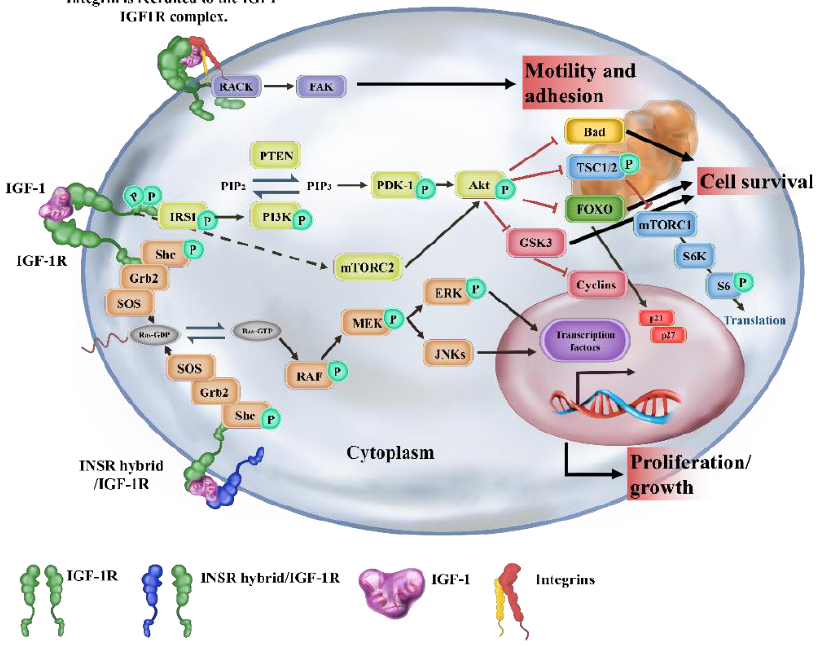
Figure 1. Downstream signaling of insulin-like growth factor-1 receptor (IGF-1R). Ligand binding to IGF-1R or IGF-1R/INSR hybrid receptors leads to the phosphorylation of tyrosines that create